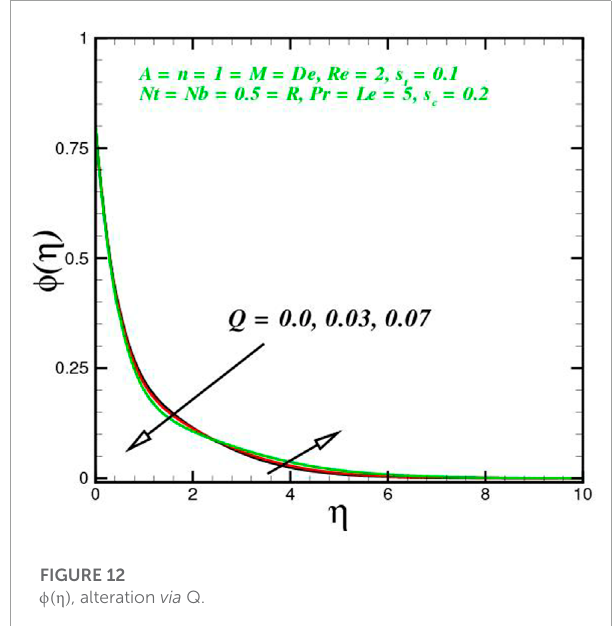
FIGURE 10 θ ( η ) , alteration via Q.